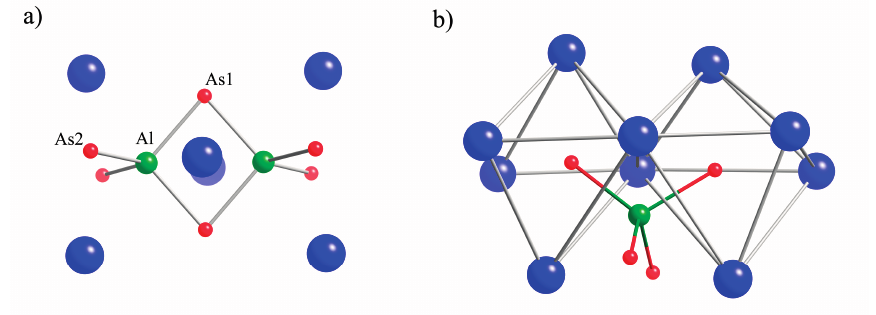
Figure 3. ( a ) The [Al 2 As 6 ] 12 − polyanion, isosteric with the diborane molecule, B 2 H 6 ; ( b ) The coordination of each As and Al atoms by Barium. The blue spheres represent the Ba atoms, the green spheres denote the Al atoms, and the red ones are the arsenic atoms,